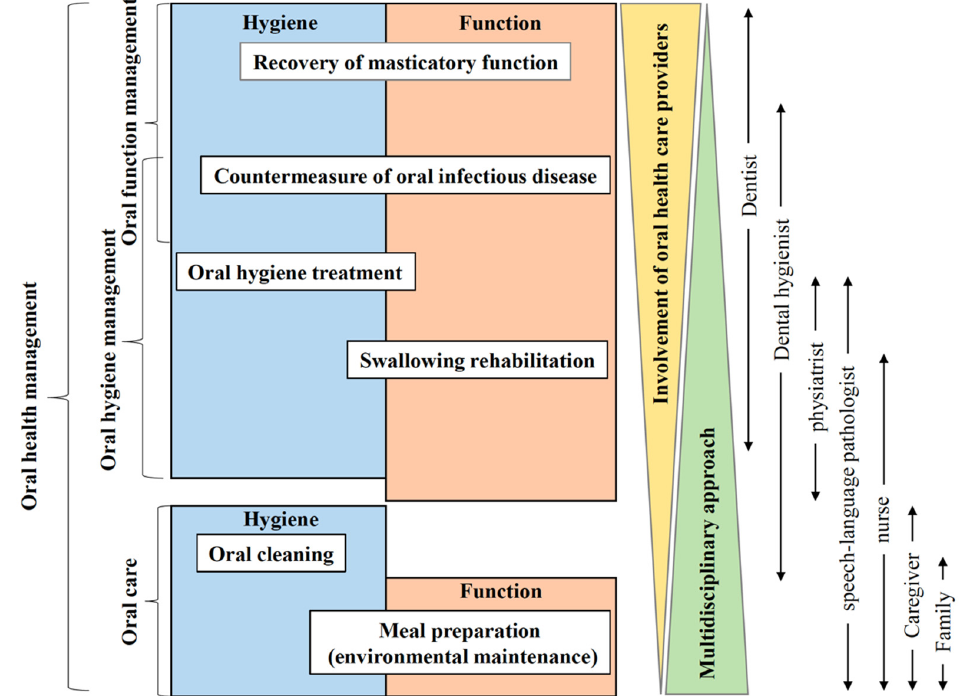
Figure 2. Oral health management in oral cancer treatment.